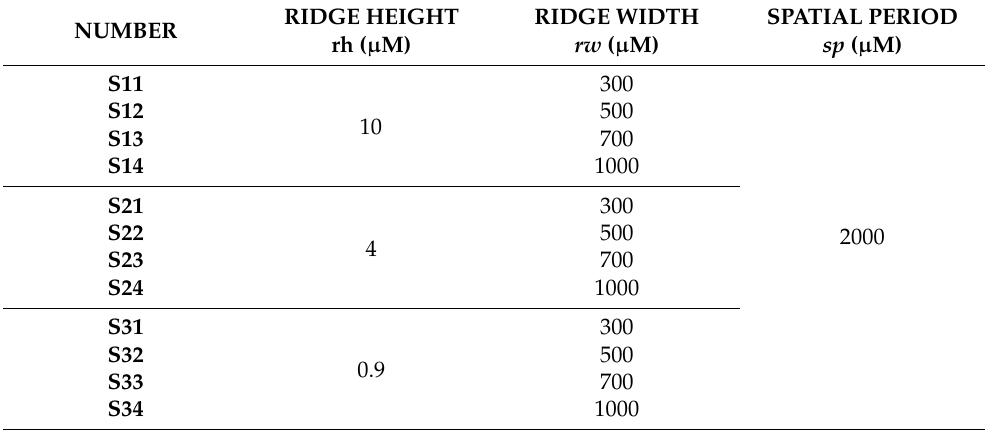
Figure 5. Experimental loading platform for texture detection: ( a ) ① prosthetic fingertip integrated with tactile sensor array, ② conditioning circuit, ③ NI-DAQ device, ④ texture sample, ⑤ fixed stage, ⑥ three-axis precision linear stage, ⑦ long-travel linear motor stage, ⑧ clamp; ( b ) silicon wafer with ridge texture; ( c ) SEM image of the micro-structure of the silicon wafer. Table 1. Parameters of ridge texture sample.